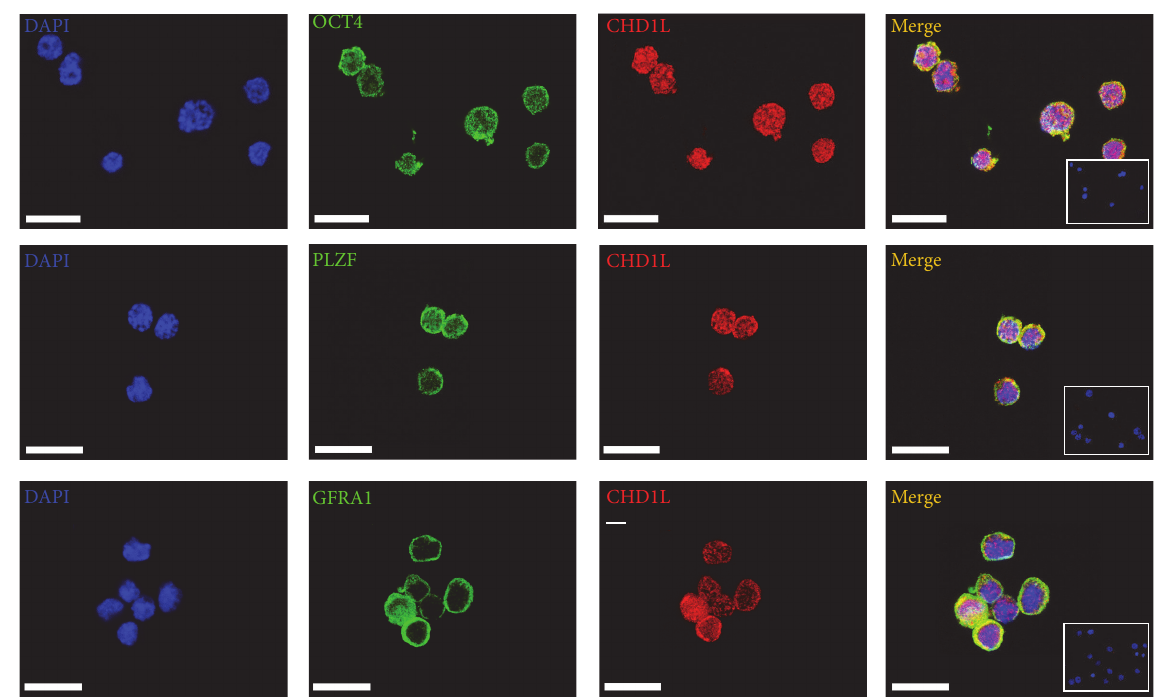
Figure 3: CHD1L is expressed in THY1 + SSCs. Immunofluorescence staining assays reveal the colocalization of CHD1L (red) with OCT4 (green), PLZF (green), and GFR Α 1 (green) in THY1 + SSCs. The THY1 + SSCs were isolated from a total spermatogonia pool, obtained from 5 dpp mouse testis, using THY1 conjugated immunomagnetic beads. Representative images from three independent experiments ( 𝑛 = 3 ) were presented here. The insert in the merged images is the IgG negative control. Scale bars represent 50 𝜇 m. SSC: spermatogonial stem cell; dpp: days postpartum; THY1 (Thy-1): thymus cell antigen 1; GFR Α 1: GDNF-family receptor 𝛼